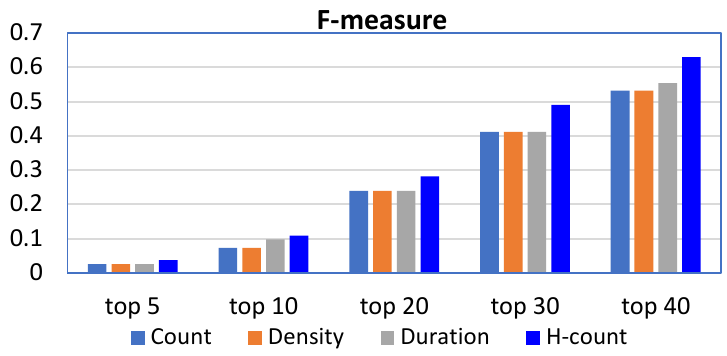
Figure 4. F-measure comparison between H-Count and three baselines.